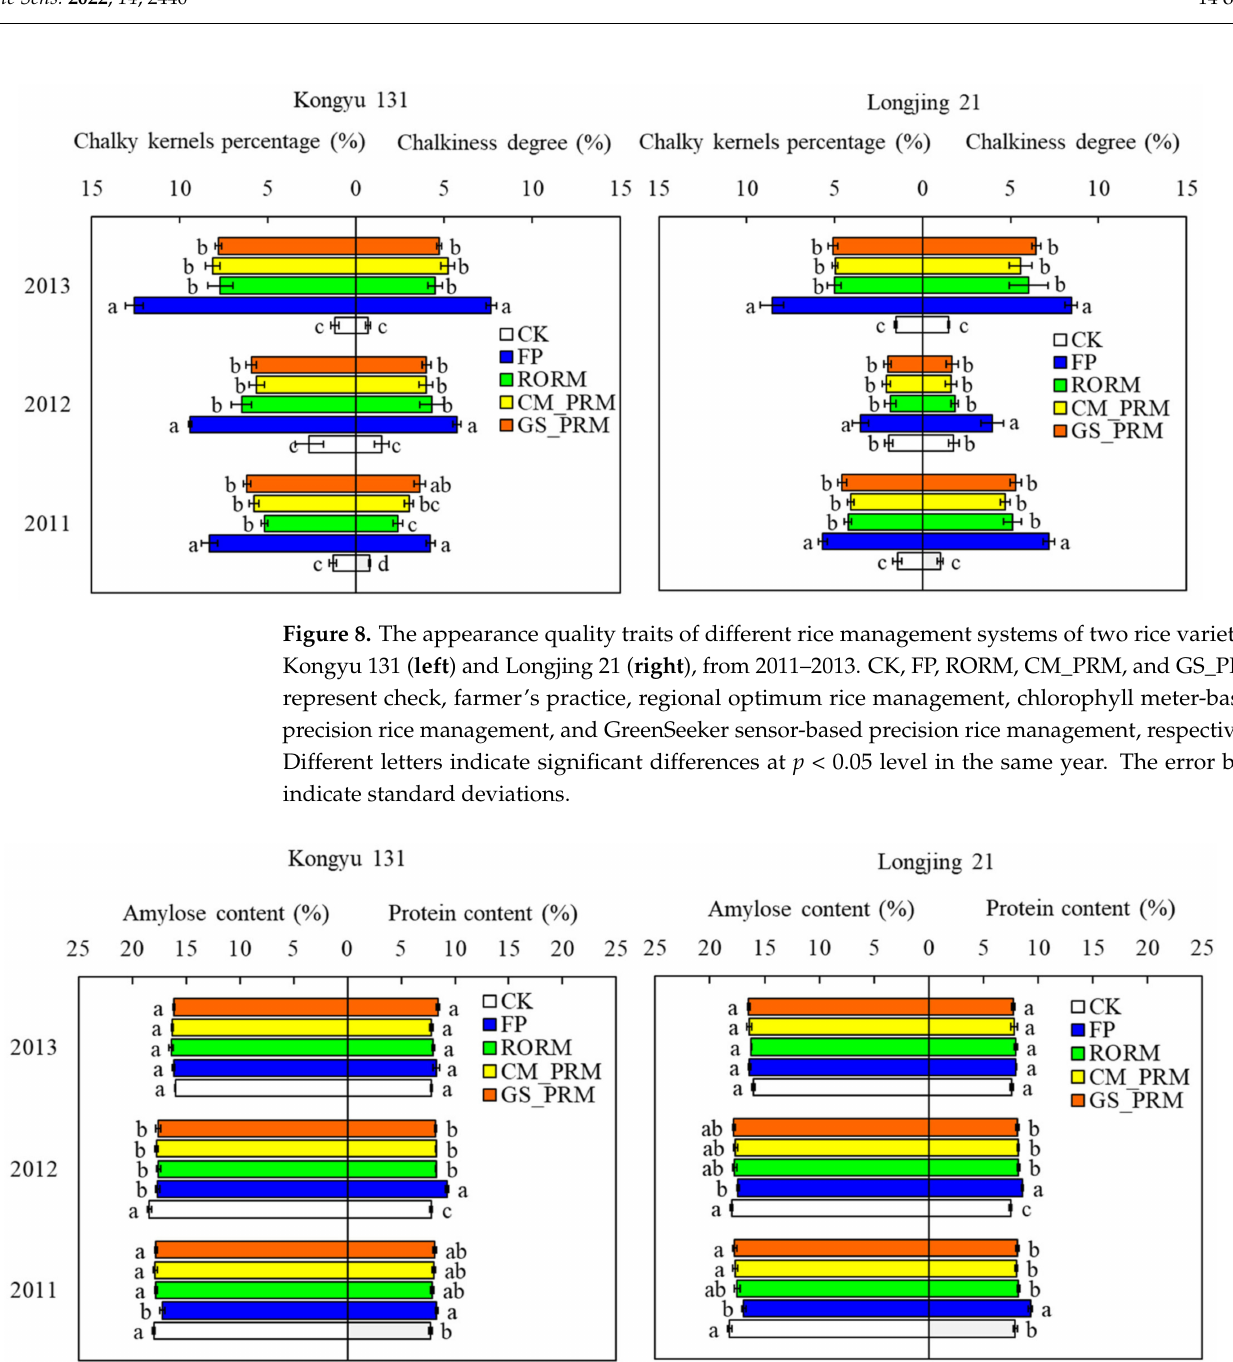
Figure 9. The nutritional quality traits of different rice management systems of two rice varieties, Kongyu 131 ( left ) and Longjing 21 ( right ), from 2011–2013. CK, FP, RORM, CM_PRM, and GS_PRM represent check, farmer’s practice, regional optimum rice management, chlorophyll meter-based precision rice management, and GreenSeeker sensor-based precision rice management, respectively. Different letters indicate significant differences at p < 0.05 level in the same year. The error bars indicate standard